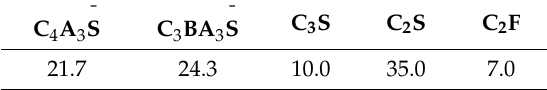
Table 2. Mineral composition design of alite (C 3 S) modified CSA (AMCSA) clinker (wt.%).